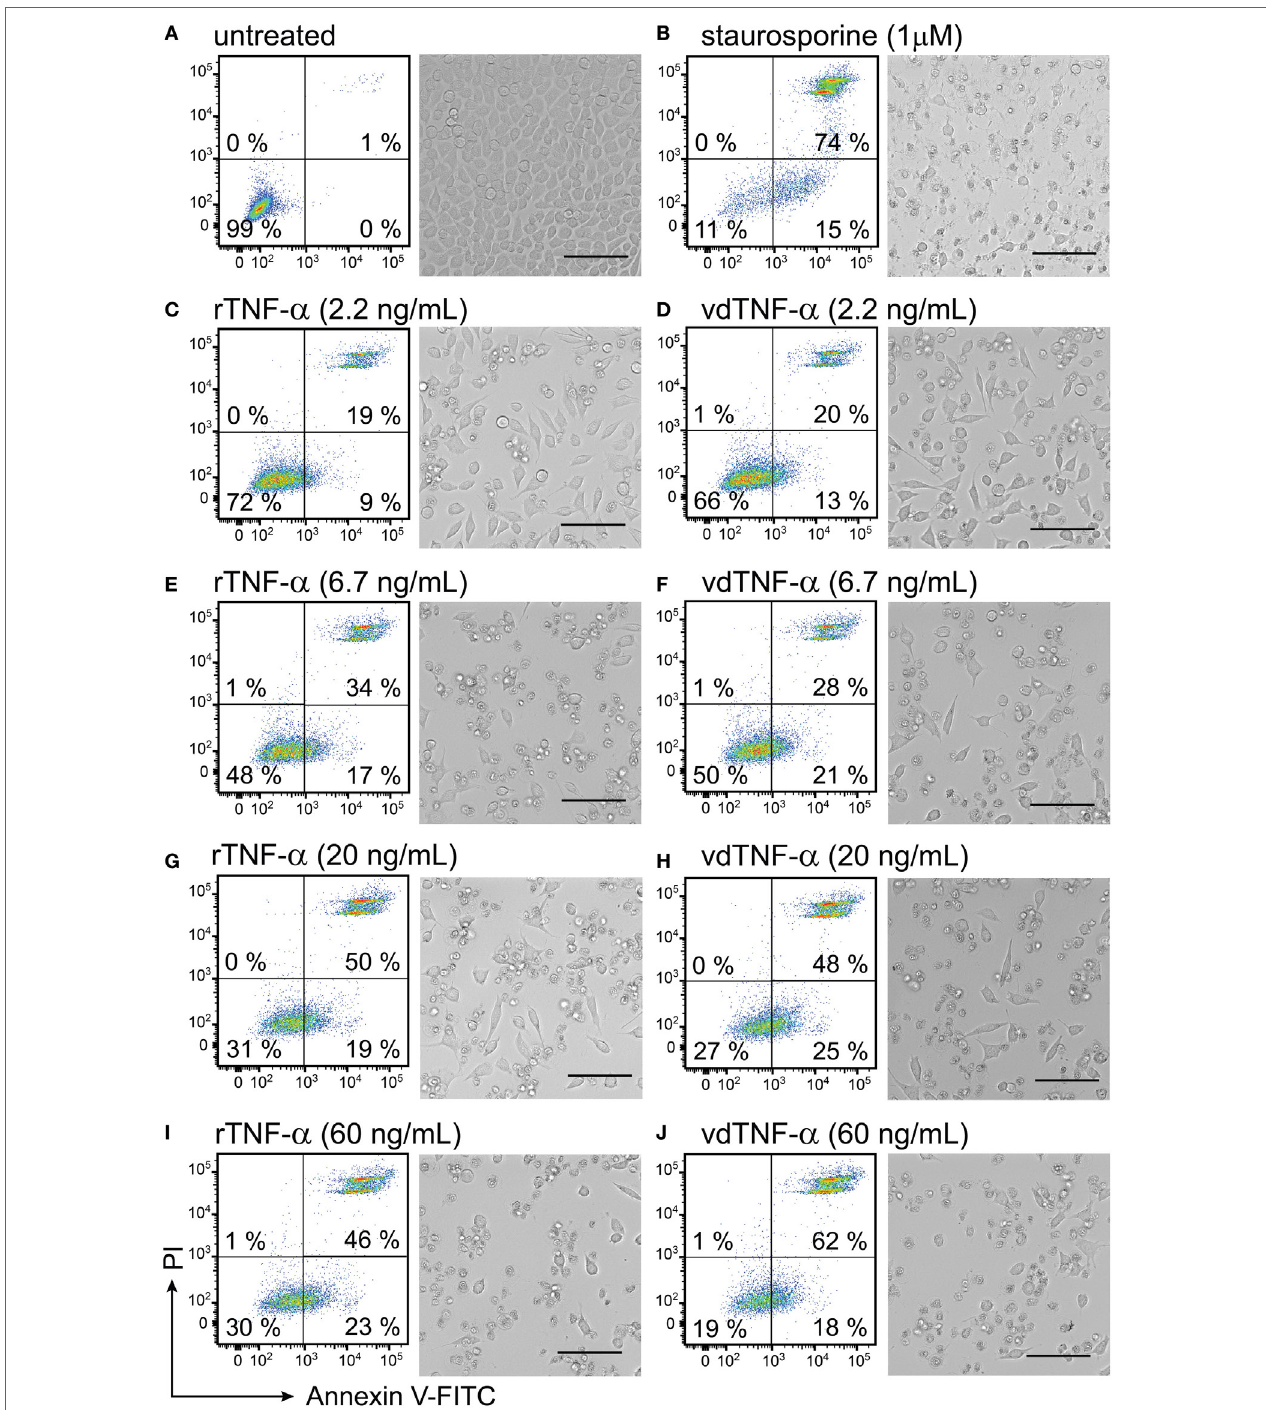
FigUre 7 | Vector-derived TNF- α induces cell death in L929 fibroblasts. L929 cells were cultured for 24 h until they reached 90% confluency. The cells were then (a) left untreated for 24 h and used as a negative control or (B) treated with 1 µM staurosporine for 24 h at 37°C and used as a positive control. The remaining cells were treated with rTNF- α or vdTNF- α for 24 h at the following concentrations: (c,D) 2.2 ng/mL, (e,F) 6.7 ng/mL, (g,h) 20 ng/mL or (i,J) 60 ng/mL. The resulting cell monolayers were analyzed using bright-field microscopy (scale bar, 50 µM). Cell death was determined using flow cytometry analysis after cell staining with annexin V-FITC (depicted on the x -axis) and propidium iodide (PI, depicted on the y -axis). Annexin V-positive/PI-negative cells were regarded as apoptotic, whereas annexin V-positive/PI-positive cells were regarded as necrotic. Two independent experiments were performed in duplicates with standard error not exceeding 10% between independent experiments. Data from one representative experiment are shown, where the percentages of the four distinct cell populations represent the averages of duplicates with SEM <